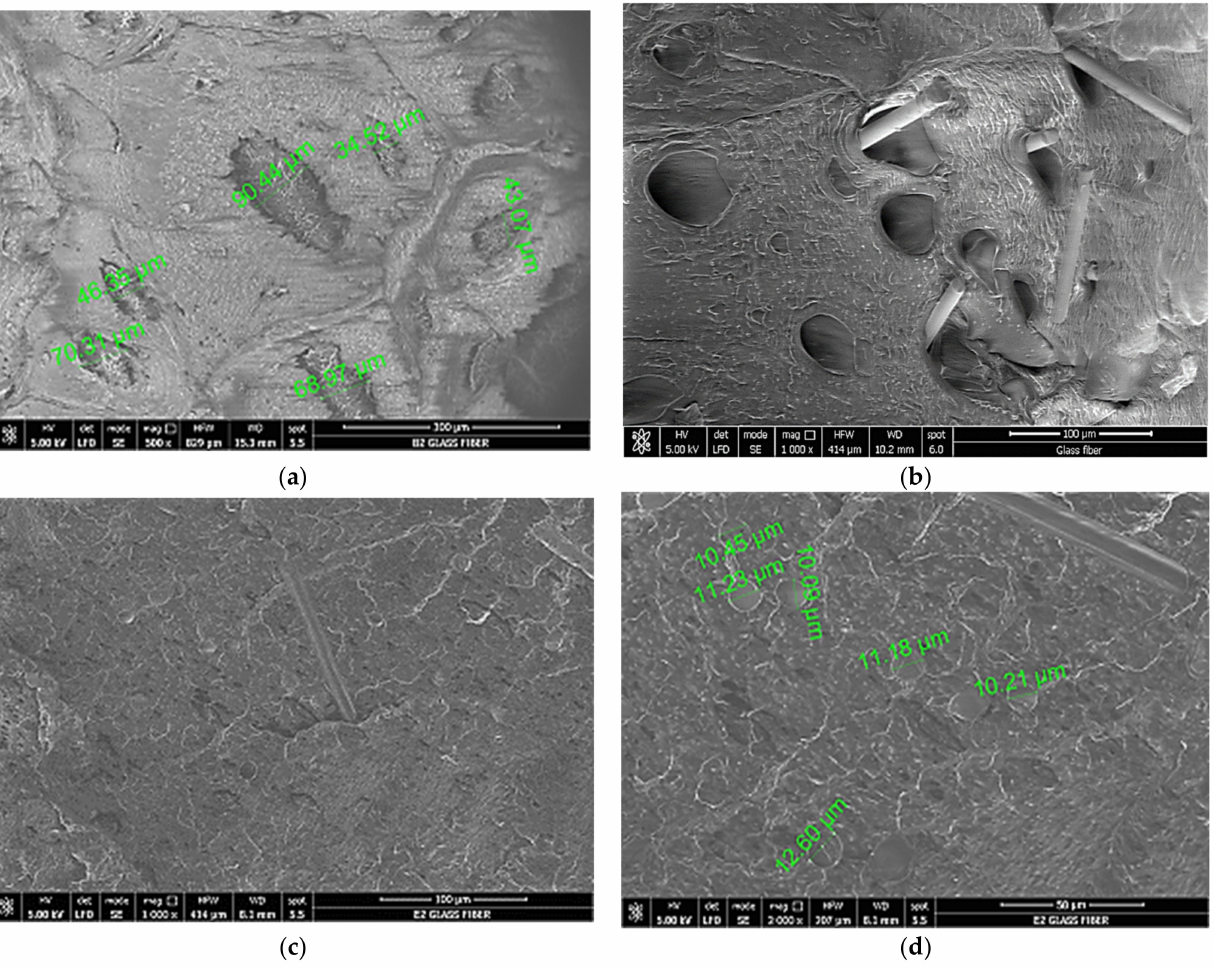
Figure 7. SEM PP composites: ( a ) cavities, ( b ) glass fiber surface, ( c ) PP-GF- modified MWCNTs, ( d ) fiber distribution in PP GF–modified